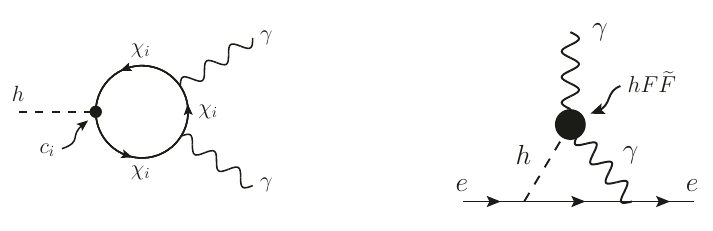
Figure 2 . Contribution to the electron EDM from